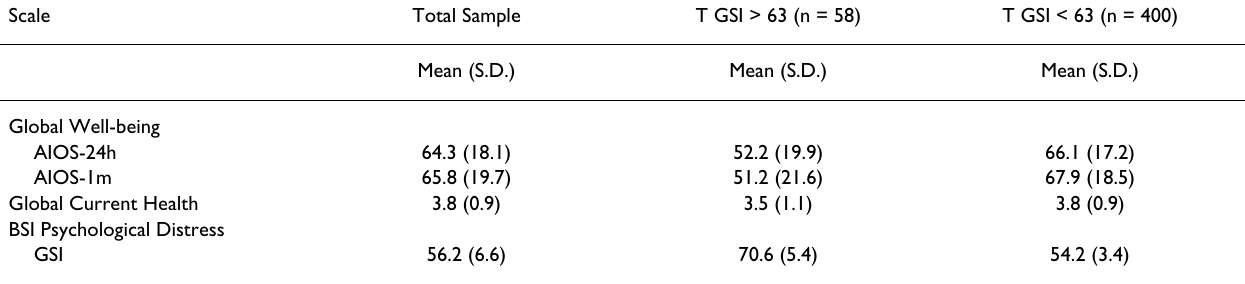
Table 3: Means Scores (S.D.) for AIOS, Global Health Ratings, and BSI GSI for Psychologically Distressed and Non-Distressed Students. Scale Total Sample T GSI > 63 (n = 58) T GSI < 63 (n = 400) Mean